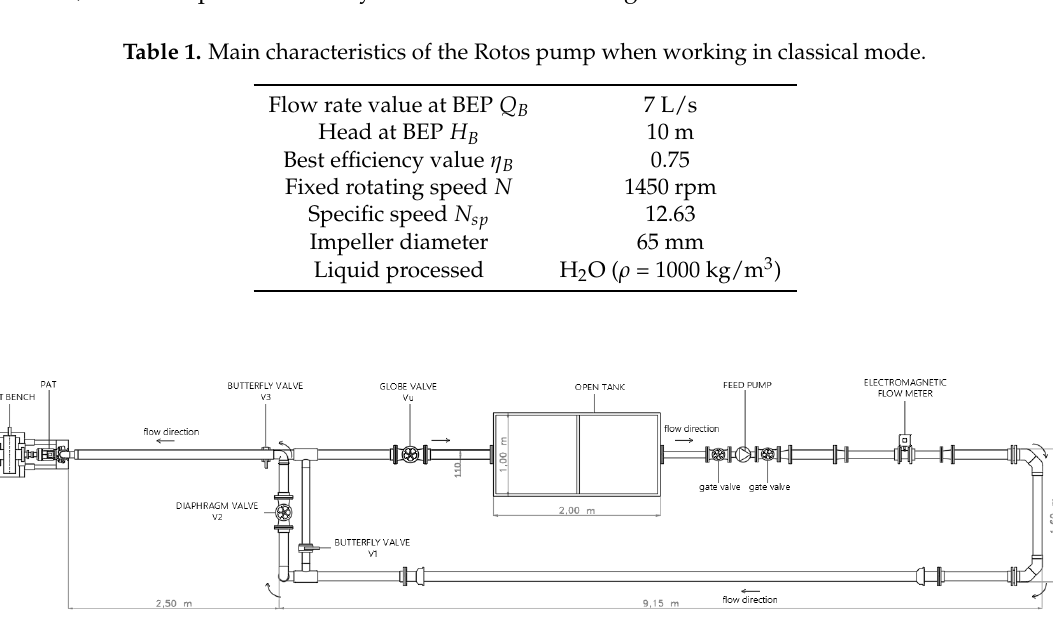
Figure 1. Top view of the experimental